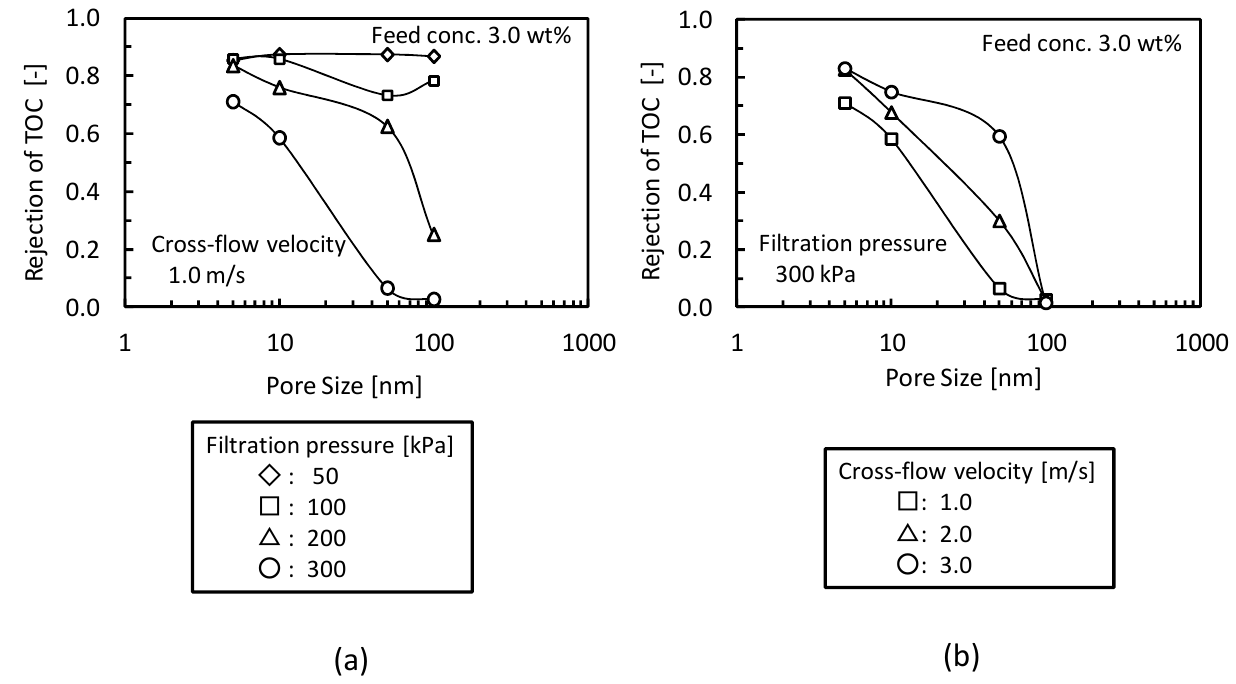
Figure 5. Effects of ( a ) filtration pressure and ( b ) cross-flow velocity on the rejection of TOC components.